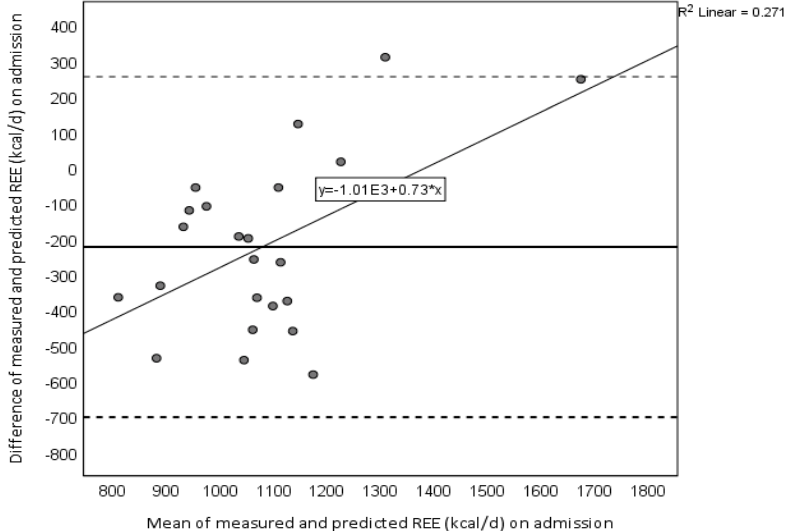
Figure 2. Bland-Altman plots displaying the agreement between measured REE by indirect calorimetry and predicted REE values by the Harris–Benedict equation on admission. Solid line indicates the mean difference and dashed lines indicate ±2 s.d.